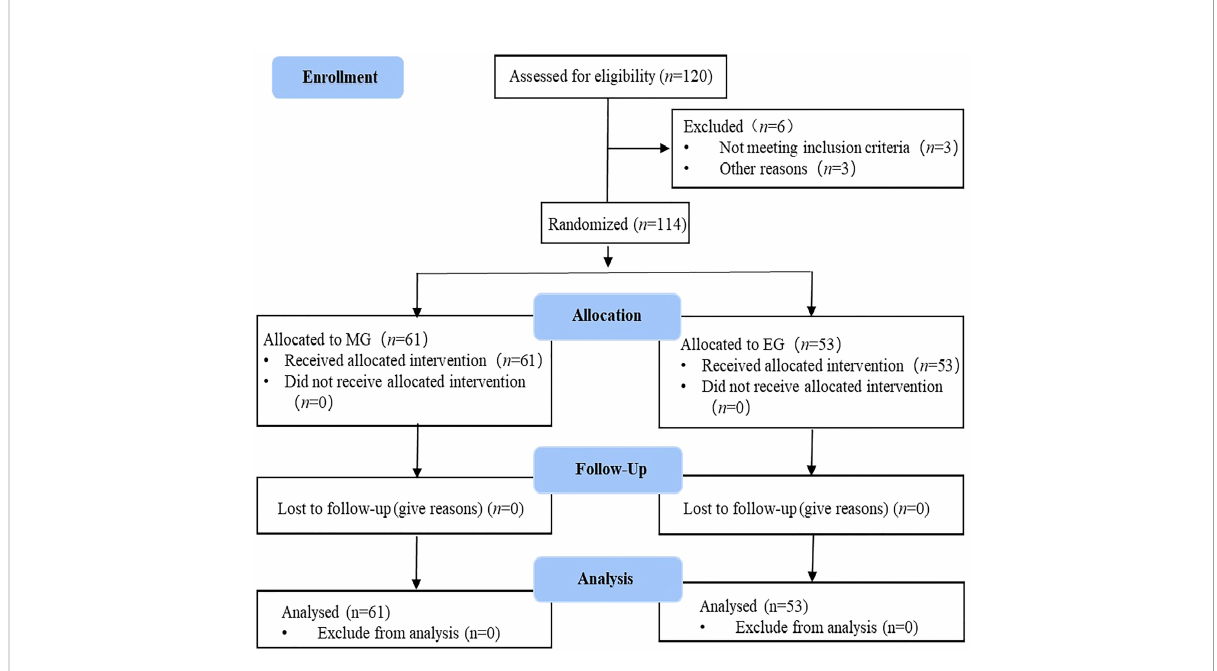
FIGURE 1 The CONSORT chart of the